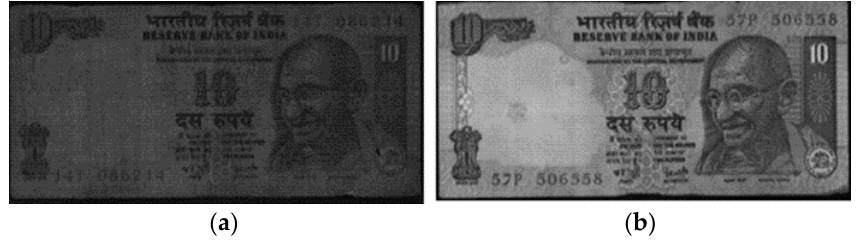
Figure 3. Example of unfit and fit banknotes (INR 10 bill): ( a ) Unfit banknote; ( b ) Fit banknote.